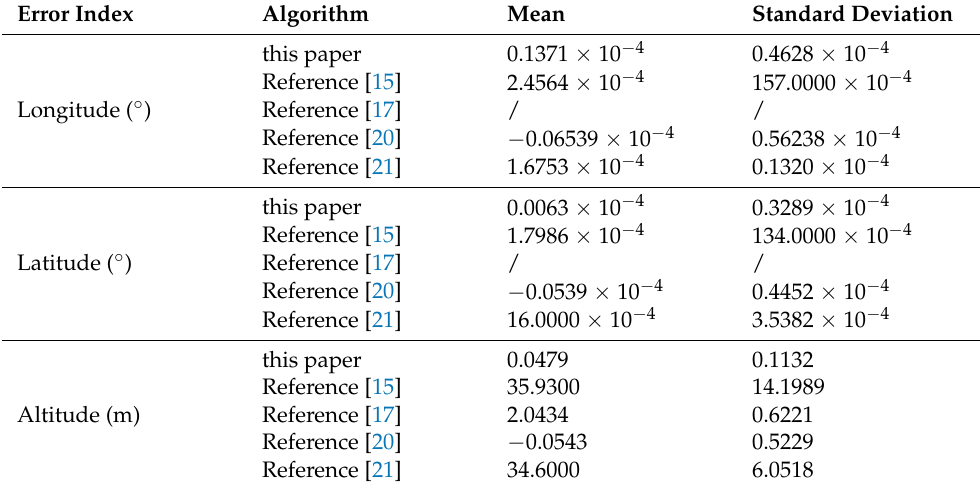
Table 4. Comparison of different